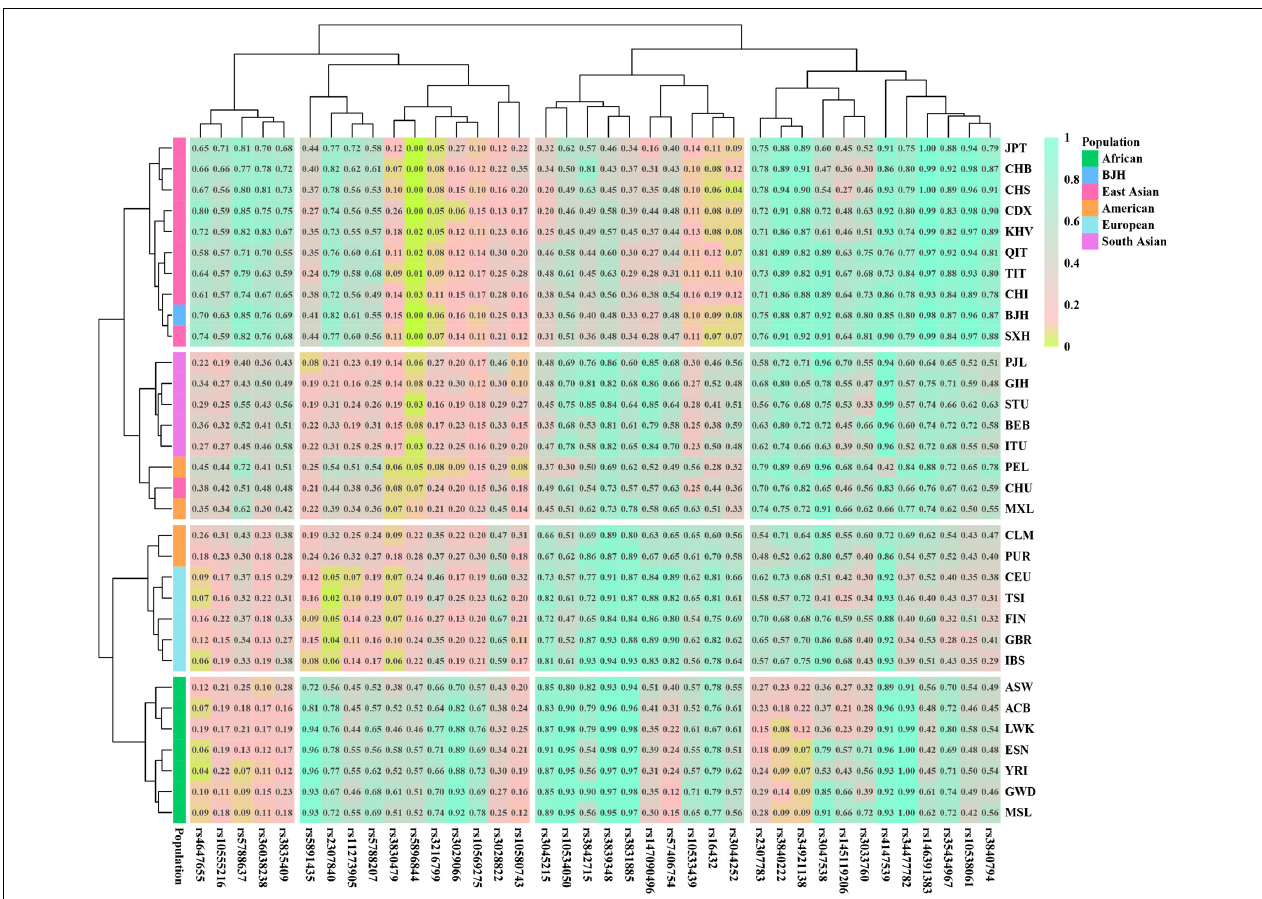
FIGURE 2 | The heat map of insertion allele frequencies of 38 AIDIPs among the Beijing Han population and 31 reference populations.